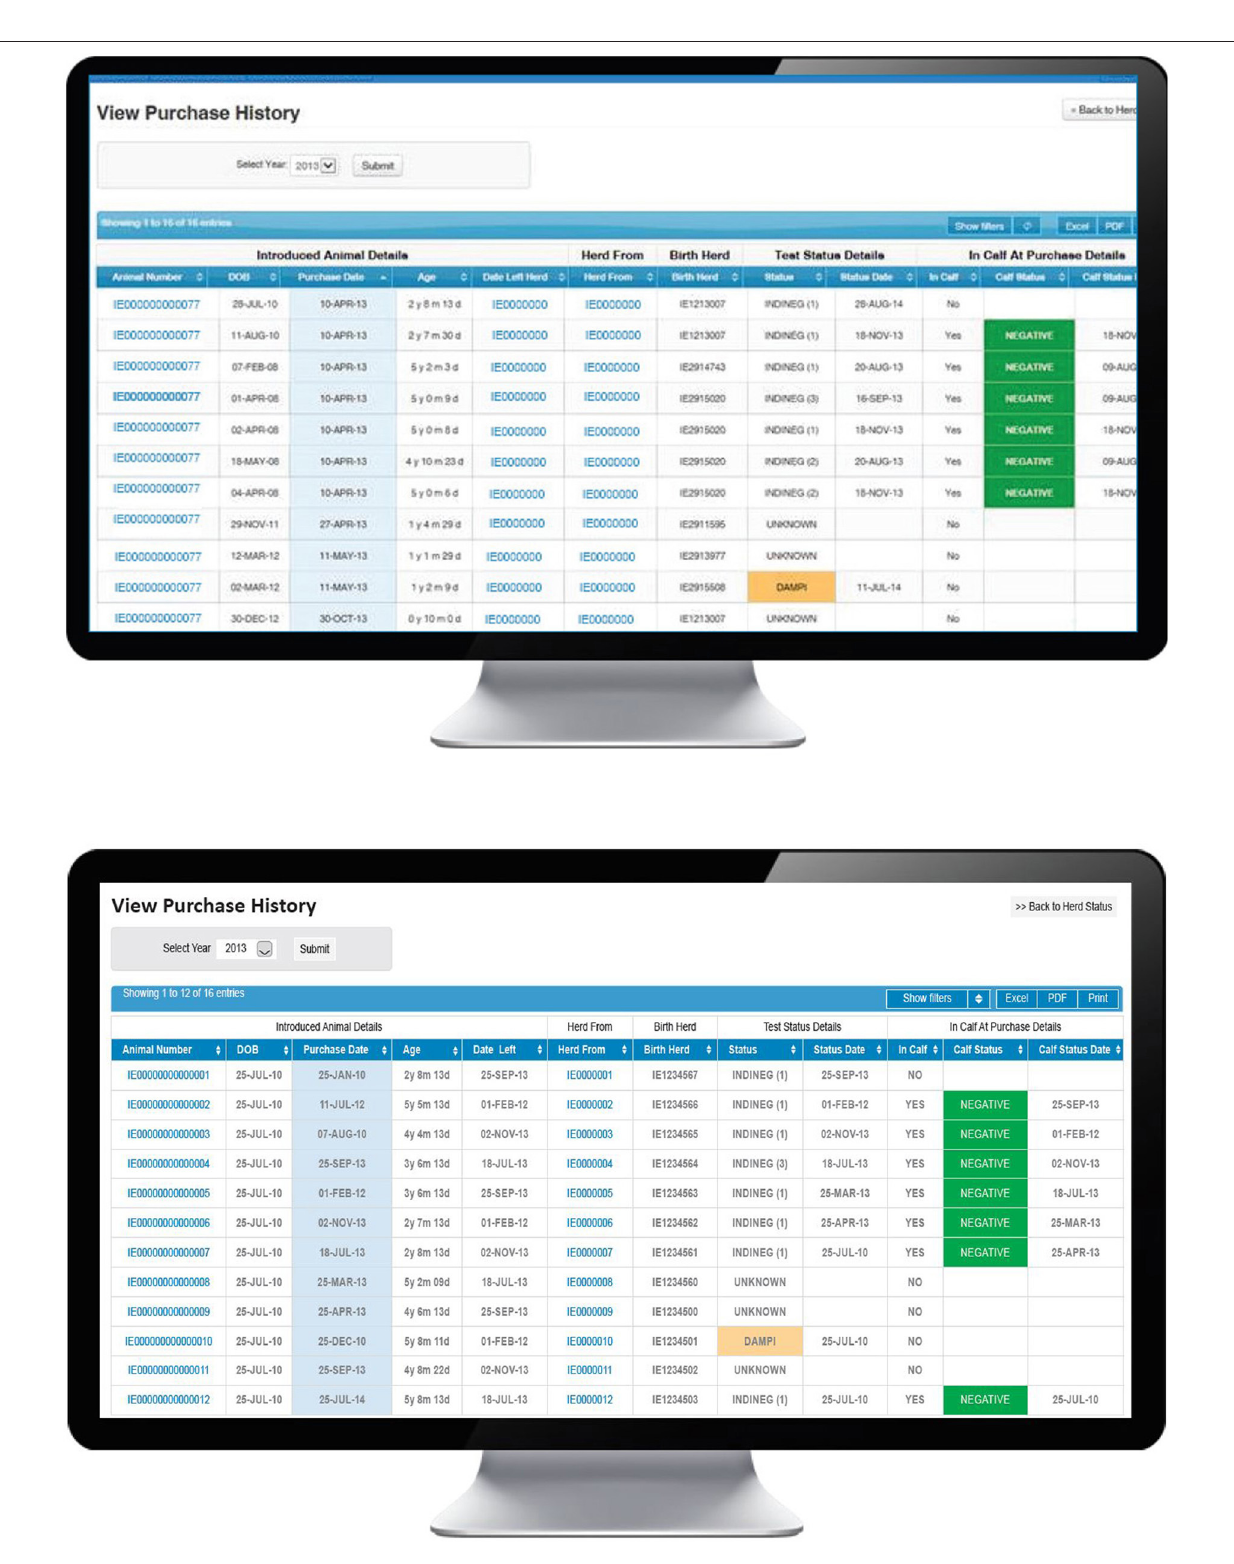
Frontiers in Veterinary Science |